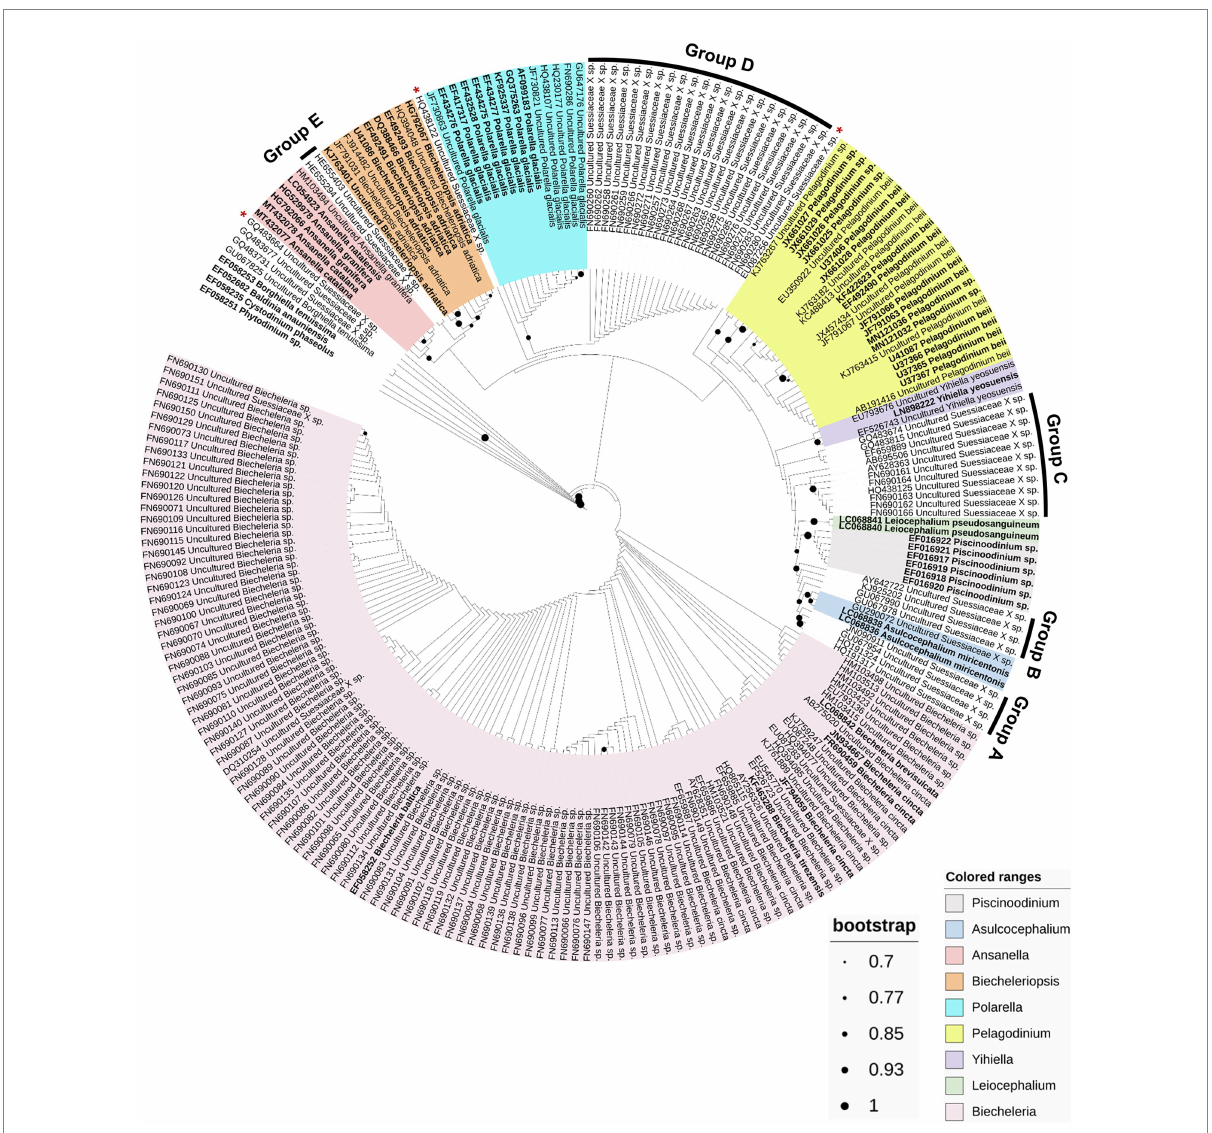
FIGURE 4 Maximum-likelihood phylogenetic tree based on 234 partial 18S rRNA gene sequences within the family Suessiaceae. The potential new taxonomic groups and sole sequences are denoted as A–E, and red asterisks (*), respectively. The strains sequenced based on the isolates are indicated in bold, and the others are environmental sequences. The colored ranges represent each genus. Bootstrap support values over 70% (0.7) are shown as dots on the interior